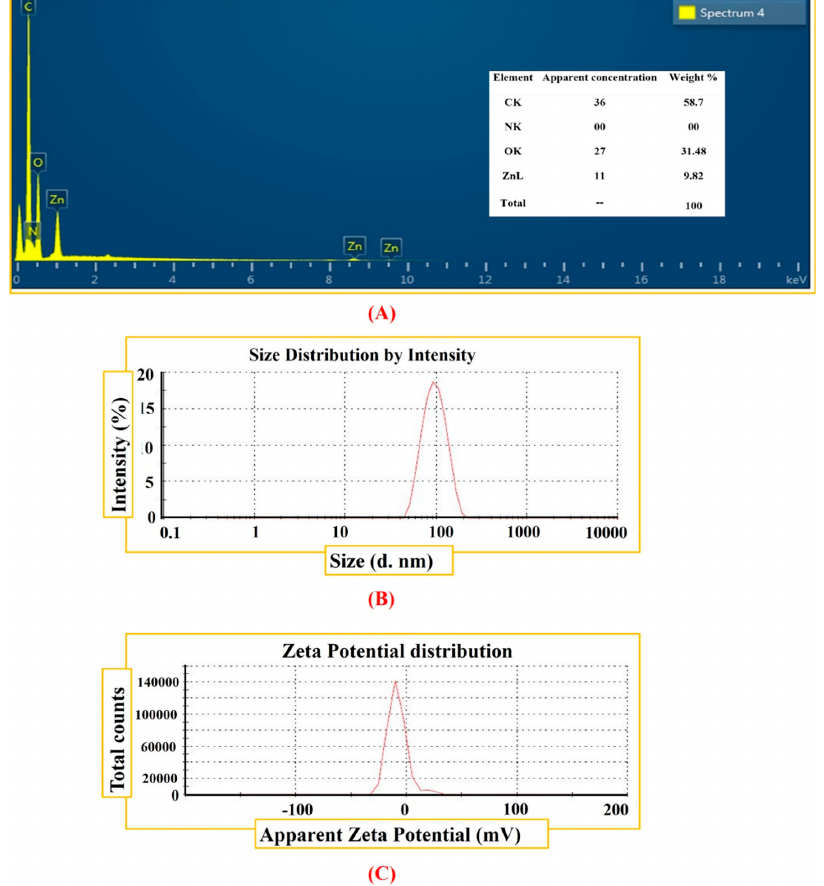
Figure 5. ( A ) Elemental composition using EDX ( B ) Size distribution of Geranium wallichianum mediated ZnONPs ( C ) Zeta potential measurement of ZnONPs.